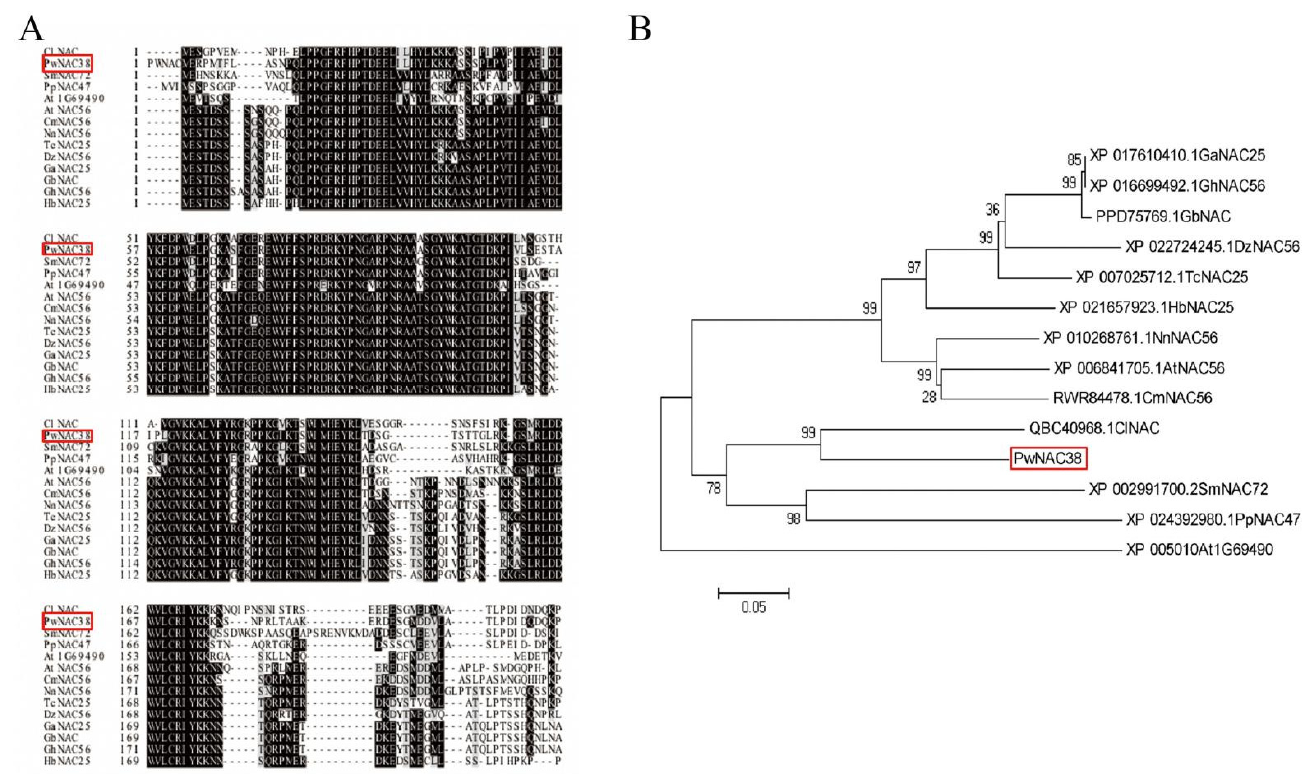
Figure 1. Multiple sequence alignment ( A ) and phylogenetic analysis ( B ) of PwNAC38 .